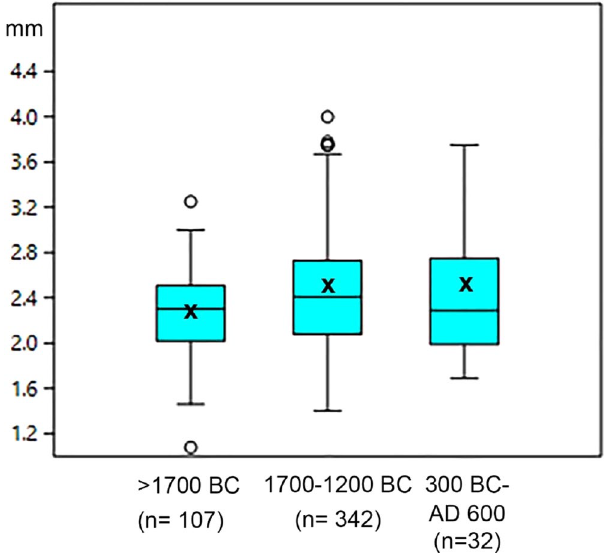
Figure 4. Boxplot of archaeological Macrotyloma seed width divided into three periods (raw data in Table S6. X indicates the mean. Means between the early phase (before 1,700 BC) and second phase (1,700–1,200 BC) are significantly different (t-test for equal mean: p = 0.00059786). Kolmogorow-Smirnov test for equal distributions between these two phases is also significantly different (p =